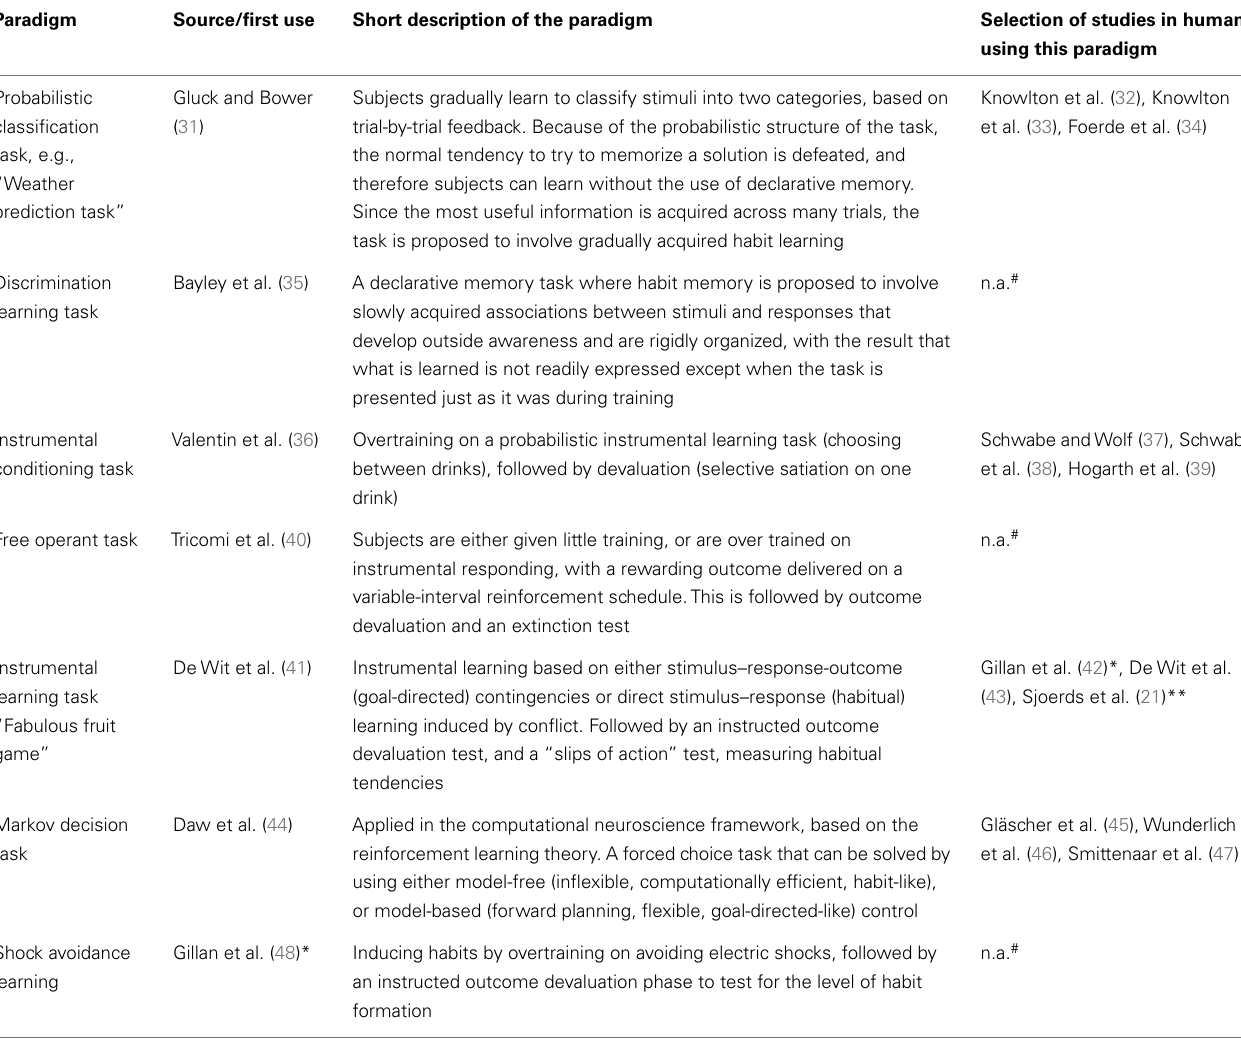
Table 1 | Examples of paradigms used to measure habit-related constructs in humans